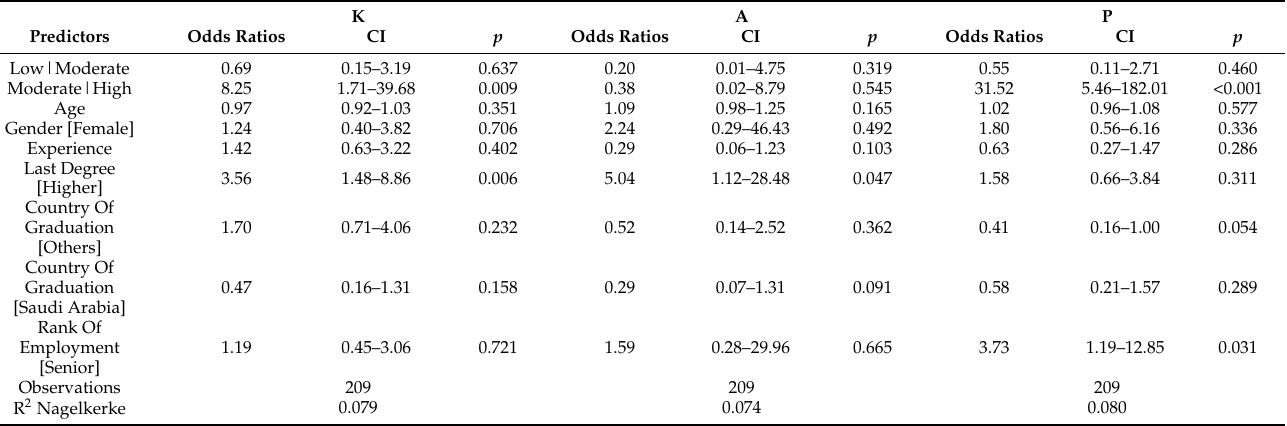
Table 7. Multiple ordinal regression to show the predictors of the ordinal 3 outcomes (knowledge, attitude, and